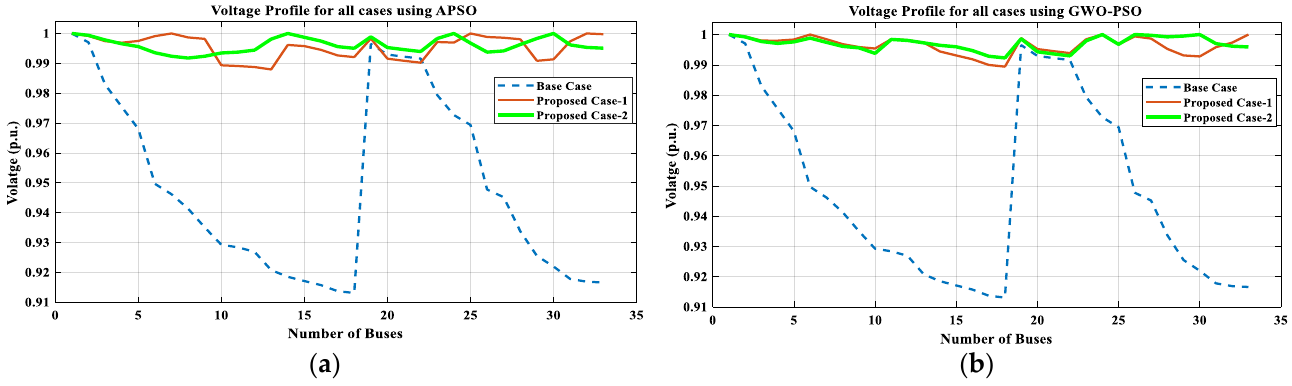
Figure 10. Voltage profile of 33-bus RDN for all cases; ( a ) APSO, ( b ) GWO-PSO. Table 8. Different cost of the IEEE 33 bus RDN.